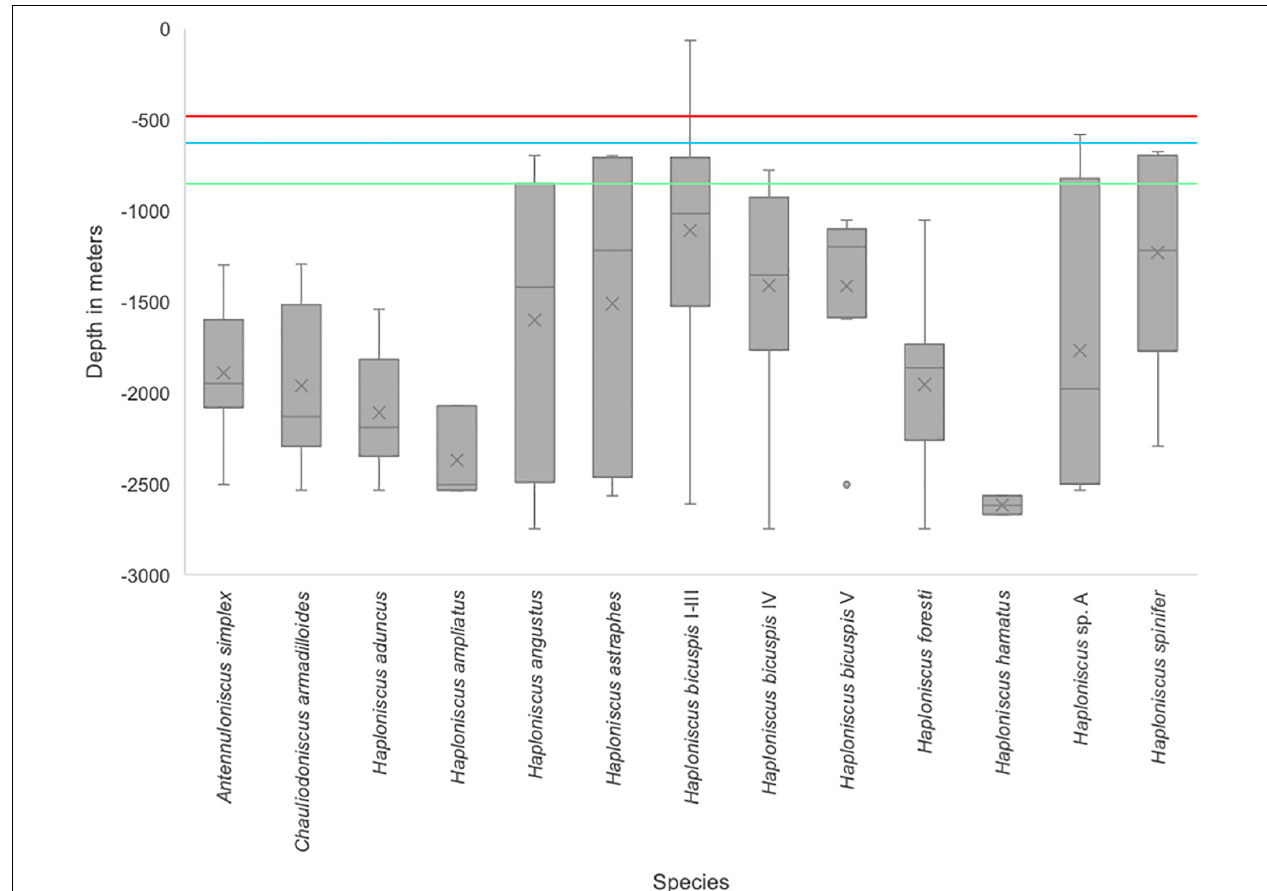
FIGURE 10 | Depth distribution of Haploniscidae species around Iceland. The colored lines mark the deepest saddle depths: 1) in the Faroe Channel at 840 m (green line), 2) between Greenland and Iceland at 620 m (blue line), and 3) between the Faroe Islands and Iceland (red line). Depth lines are implemented following the information Hansen and Østerhus (2000) and Brix and Svavarsson